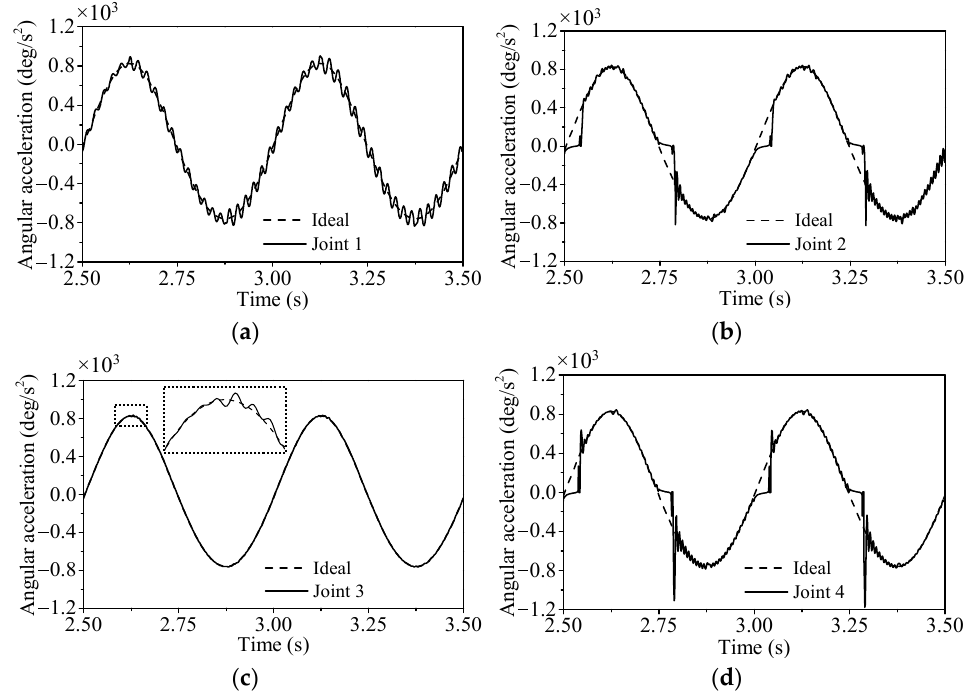
Figure 11. Angular acceleration of the rigid system with different clearance joint position: ( a – d ) joints 1,2,3,4.